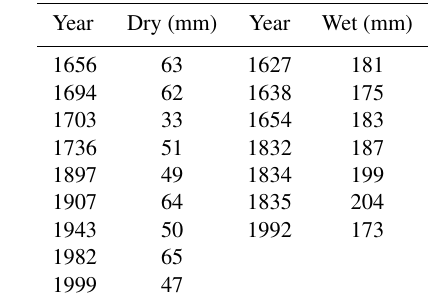
Table 3. Extreme wet and dry NGS